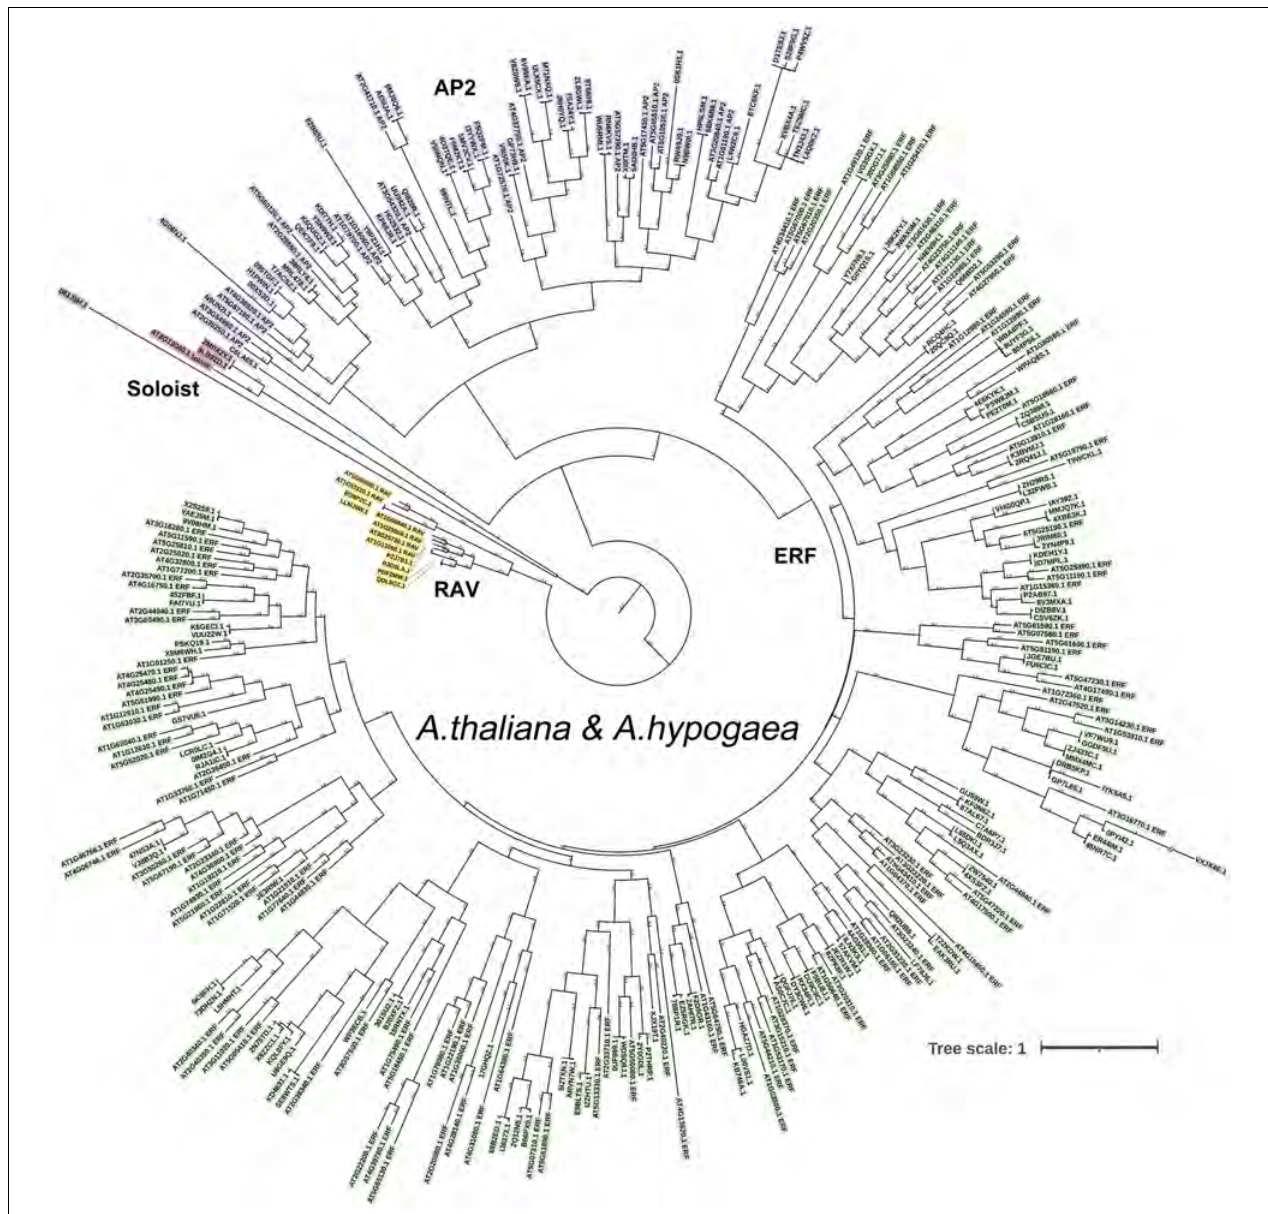
FIGURE 3 | Phylogenetic tree of AhAP2/ERFs and AtAP2/ERFs.